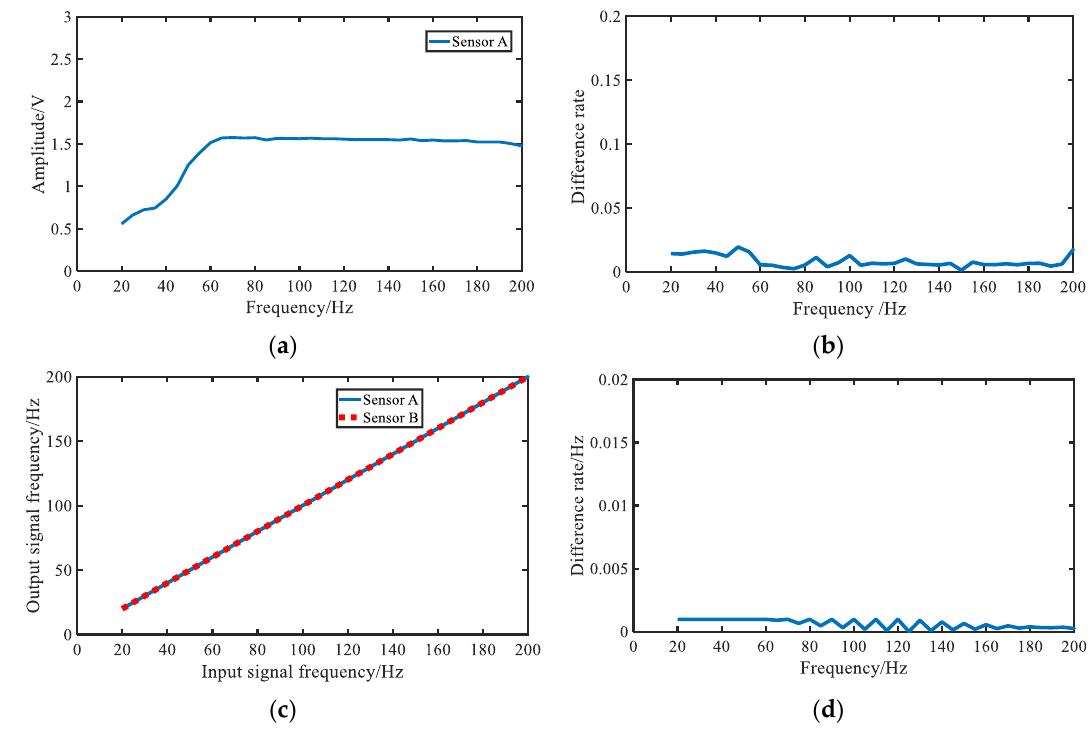
Figure 8. Results of the sensor tests. ( a ) Frequency response in test range of Sensor A; ( b ) difference rates in amplitude of the output signals between the test sensors at the same frequency; ( c ) differences in output signals frequency between the test sensors; ( d ) difference rates of frequency between the output signals of the test sensor and the ideal signals.